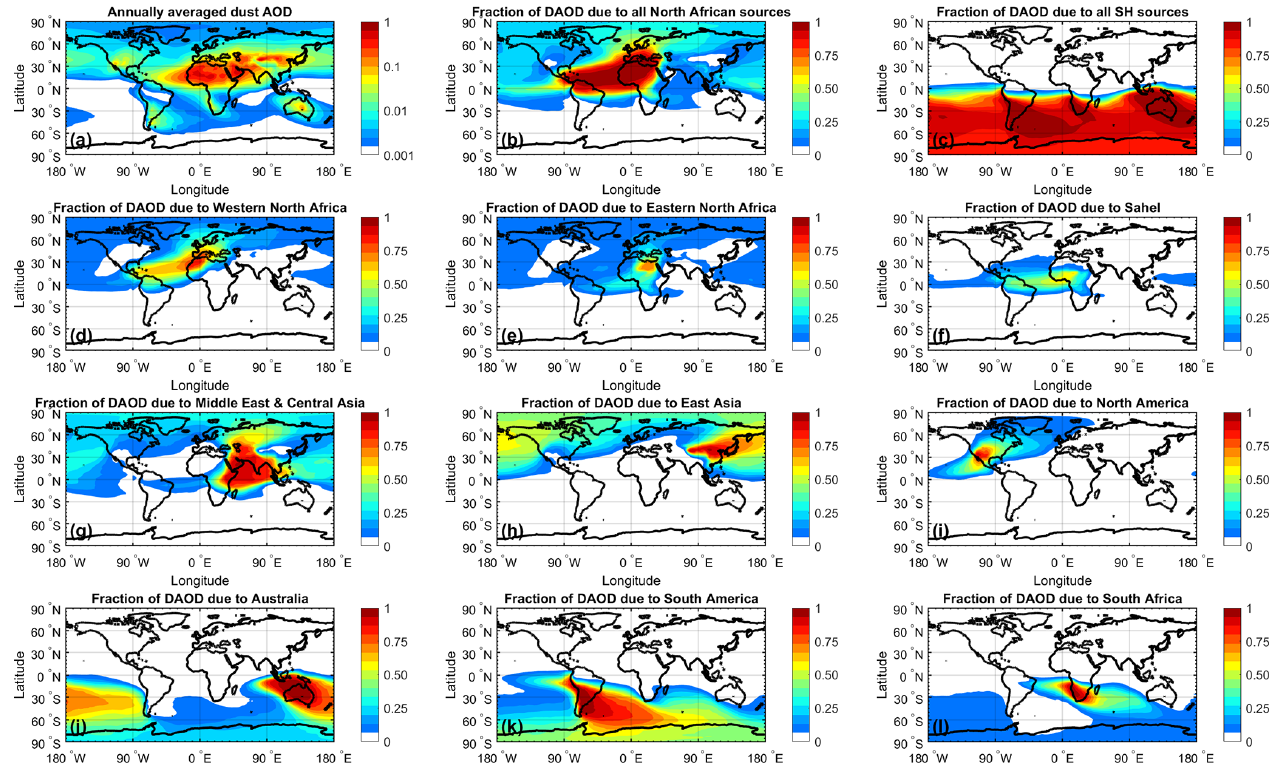
Figure 5. Attribution of the annually averaged DAOD to the world’s main dust source regions. Shown first is (a) the annually averaged DAOD produced from all source regions combined, followed by the fraction of DAOD that is due to (b) all North African and (c) all Southern Hemisphere source regions. The fraction of DAOD due to each of the three North African source regions is shown in panels (d) – (f) , and the fraction of DAOD due to the other three Northern Hemisphere source regions of the Middle East and central Asia, East Asia, and North America is shown in panels (g) – (i) . Finally, the fraction of DAOD due to the three Southern Hemisphere source regions of Australia, South America, and southern Africa is shown in panels (j) – (l) . Attributions of seasonal DAOD to the different source regions are shown in Figs.